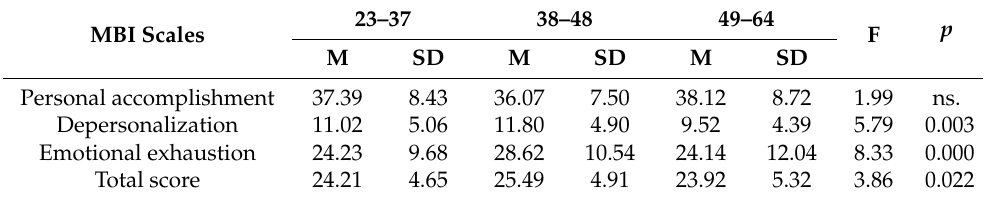
Table 10. Intergroup means comparison for age and burnout (general score and individual scales).